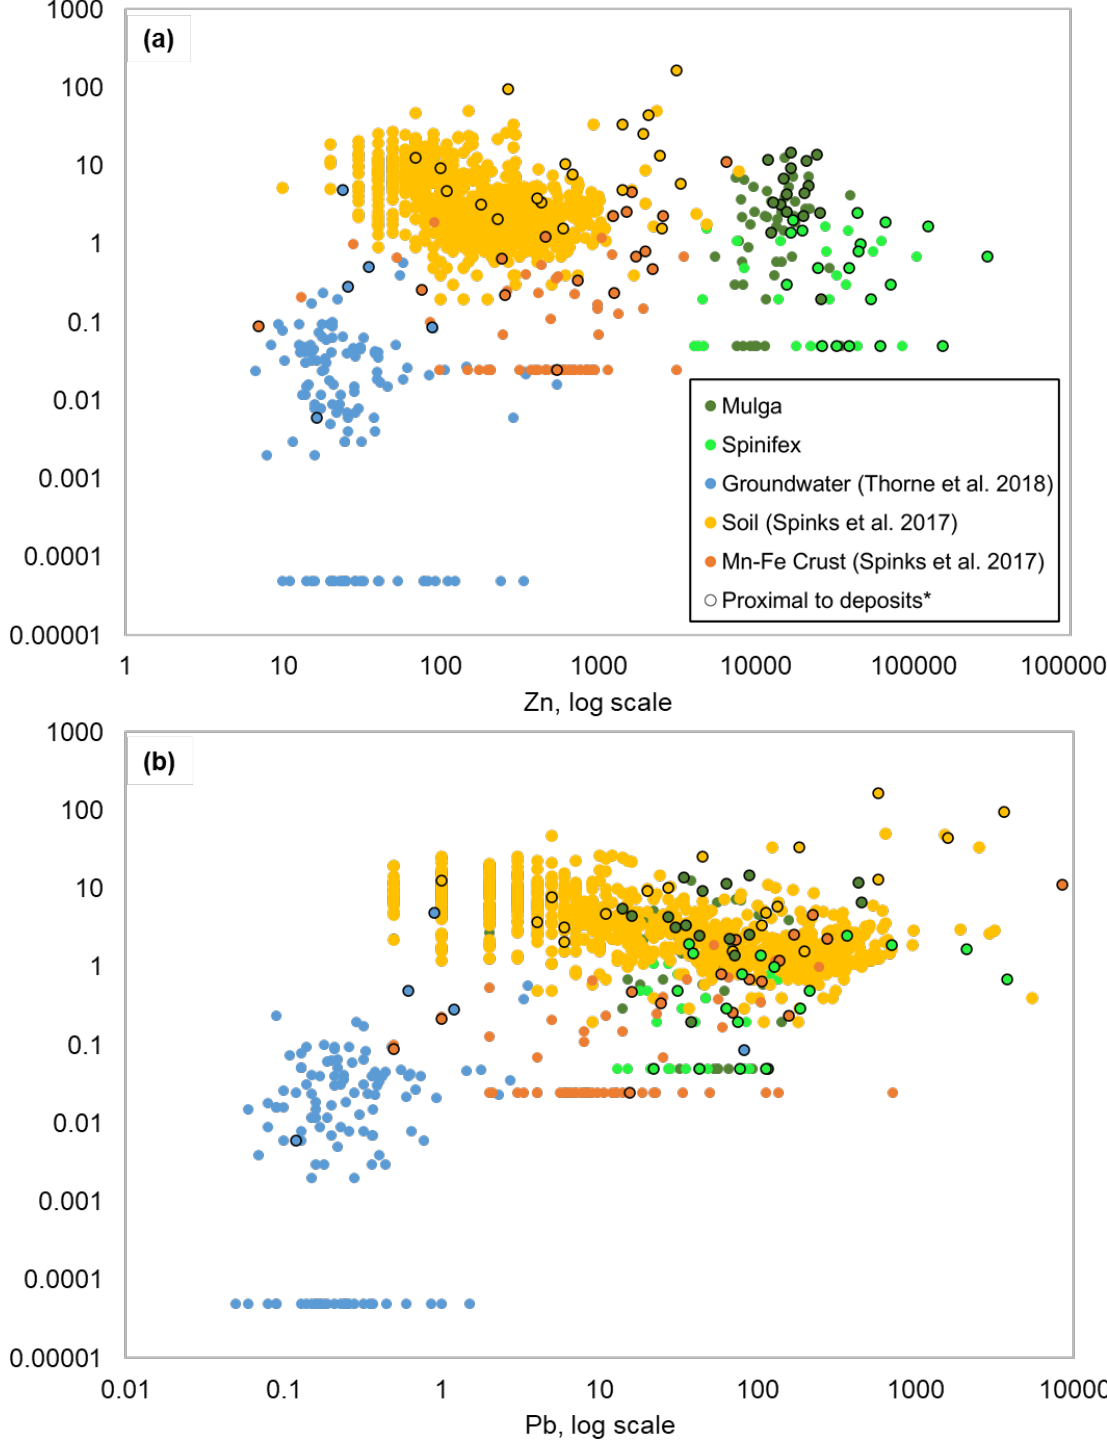
Figure 7. Logarithmic scatter plots of metal concentrations (ppb) in samples by media. Values below detection limits have been replaced by half detection limit values. ( a ) Silver over Zn. ( b ) Silver over Pb. * Samples proximal to deposits were defined as follows: groundwater—5 samples along fault line over Prairie Wolf deposits; mulga and spinifex—samples from transects T2 and T3 (including those not directly above the deposit); soil and Mn–Fe crust—samples directly above the Prairie and Wolf deposits as defined in Figure